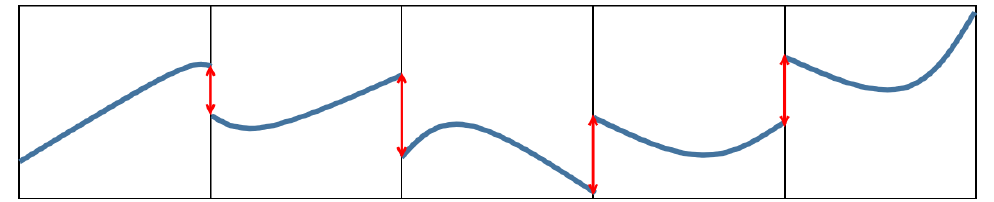
Figure 4. The illustration of the fitness function, which is the sum of the distances between the first and the last elements of the segments, as indicated with red